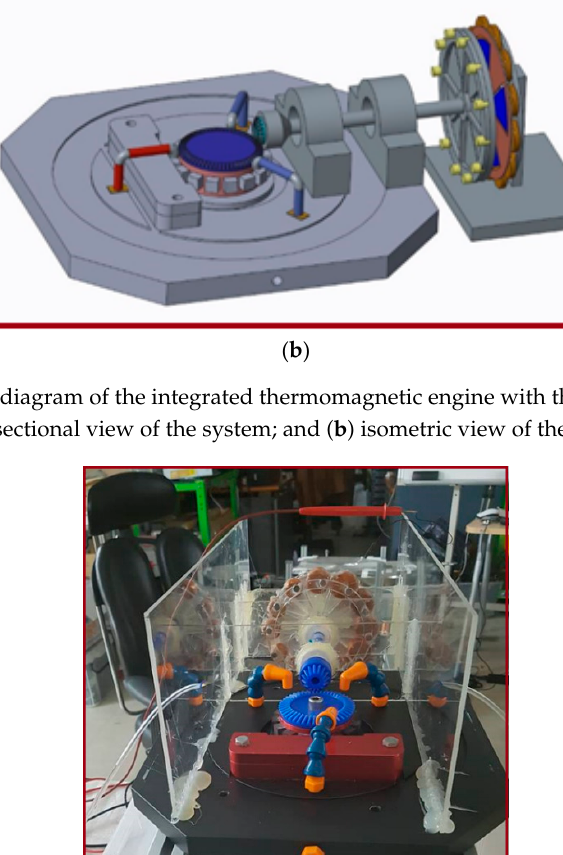
Figure 6. Fabricated model of the integrated thermomagnetic engine with the hybrid (TENG-EMG).